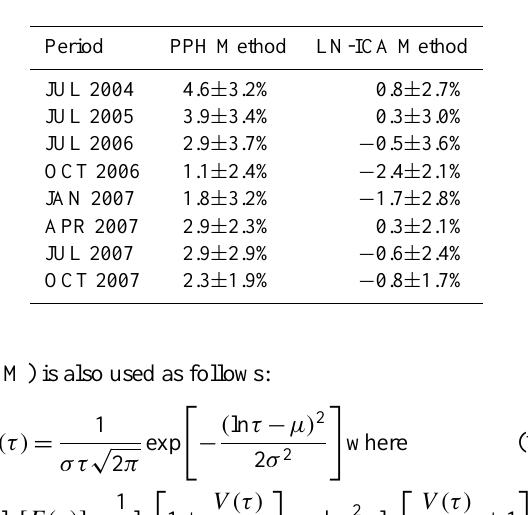
Table 1. Monthly mean differences of simulated 0.5 ◦ -grid re- flectances from observed grid reflectances at the MODIS 0.646-µm channel. PPH and LN-ICA methods are used to simulate grid re- flectance. The uncertainty ranges are estimated with a 68% confi- dence level ( ± one standard